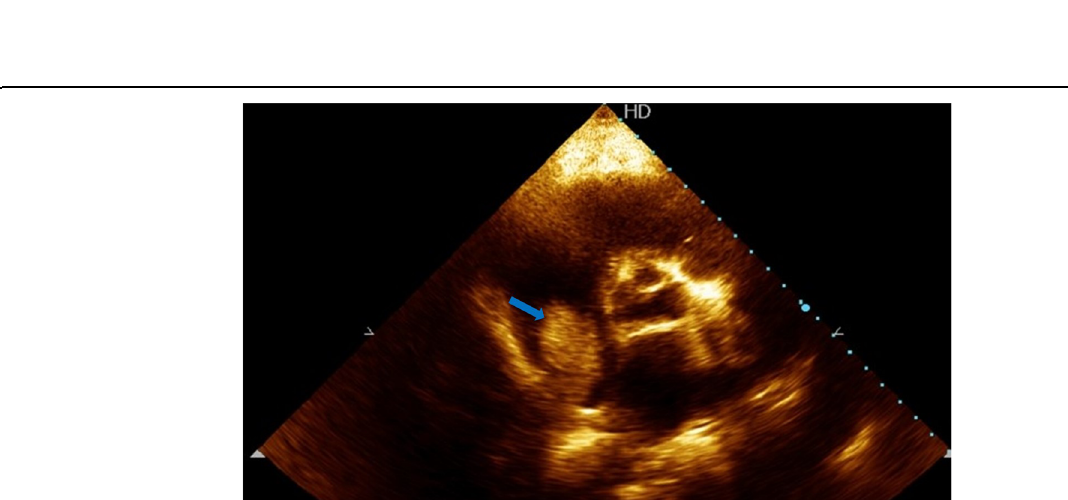
Fig. 3 TTE parasternal short-axis view showing a large mass in the right atrium arising from the inferior vena cava marked by a blue